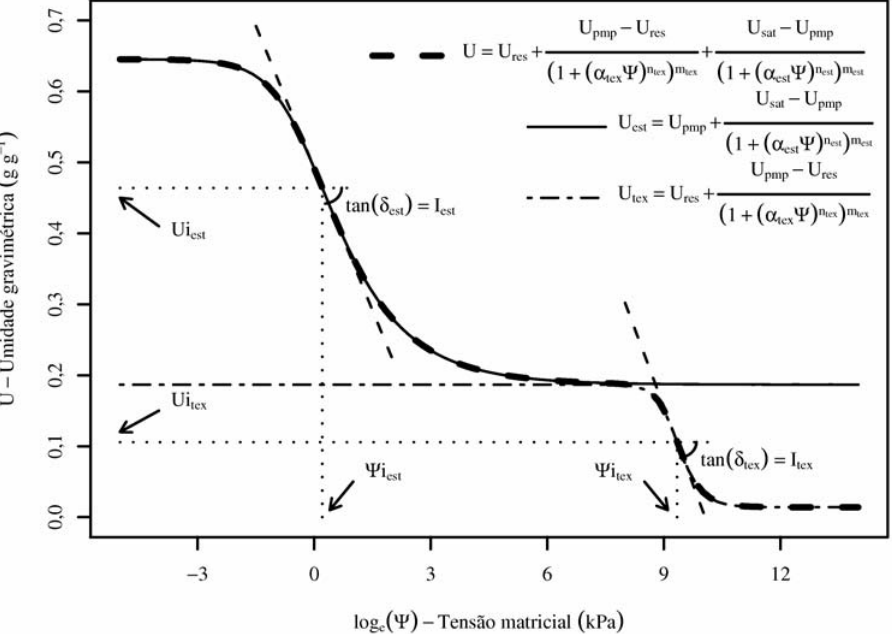
Figura 1. Modelo sugerido de ajuste da função duplo van Genuchten para a curva de retenção de água no solo, com as localizações dos parâmetros associados ao modelo, sendo potencial matricial ( ψψψψψ de água (Ui) e estimativa da primeira (I